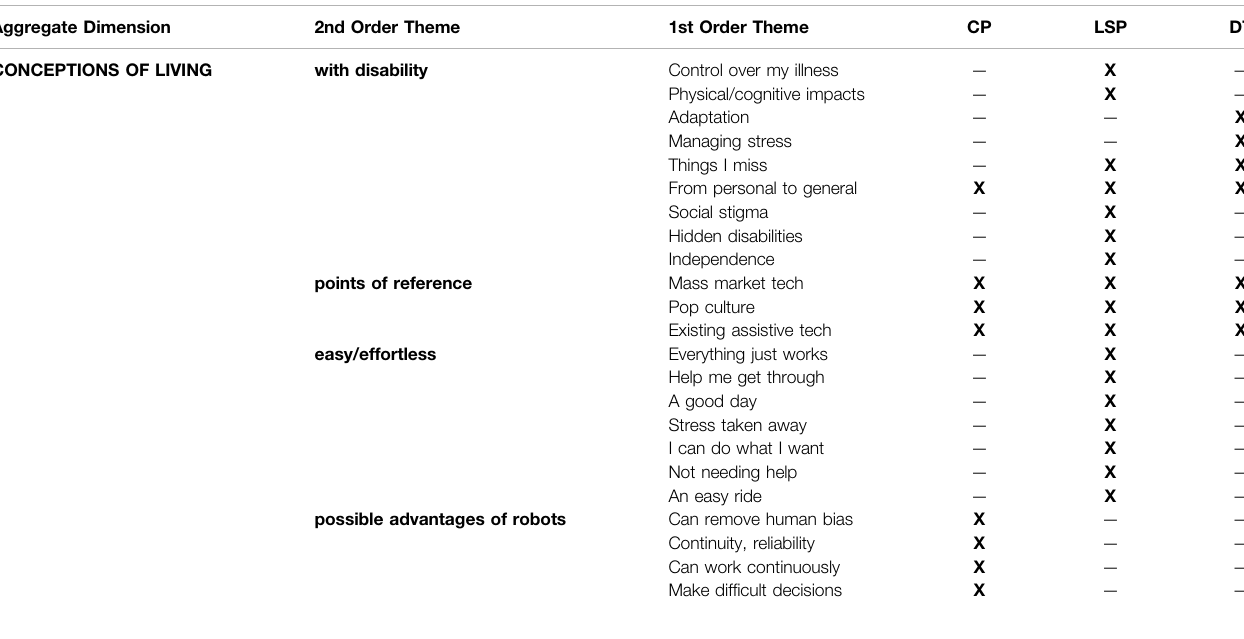
TABLE 1 | Conceptions of living. Aggregate